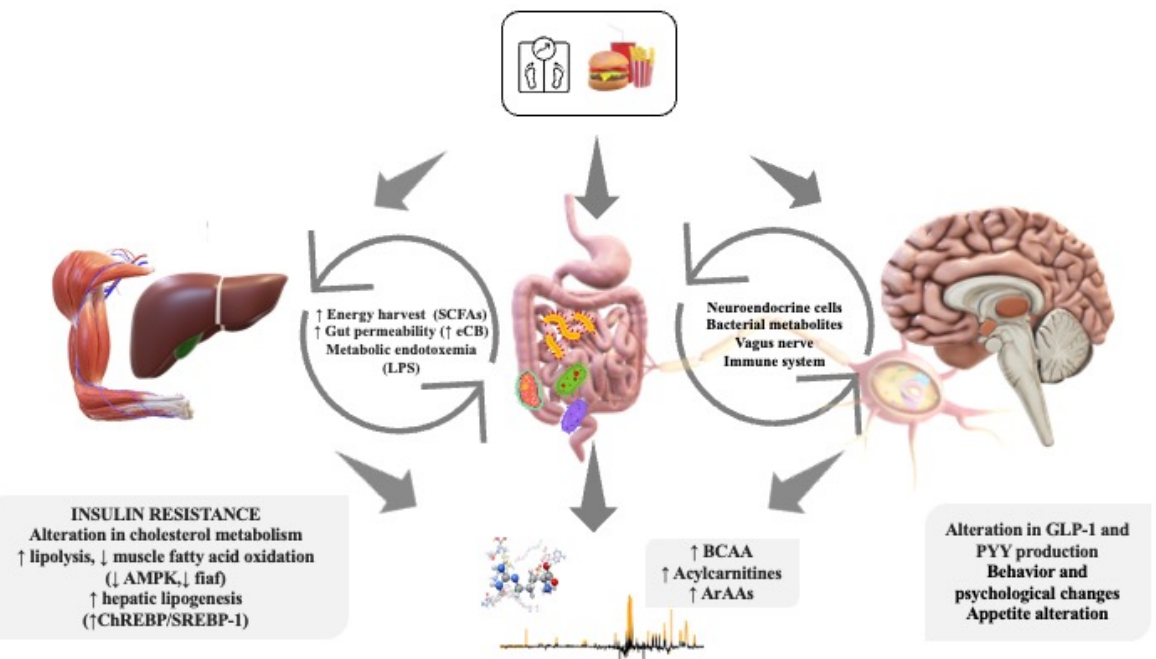
Figure 1. Connection between diet, gut microbiota, and metabolomics in childhood